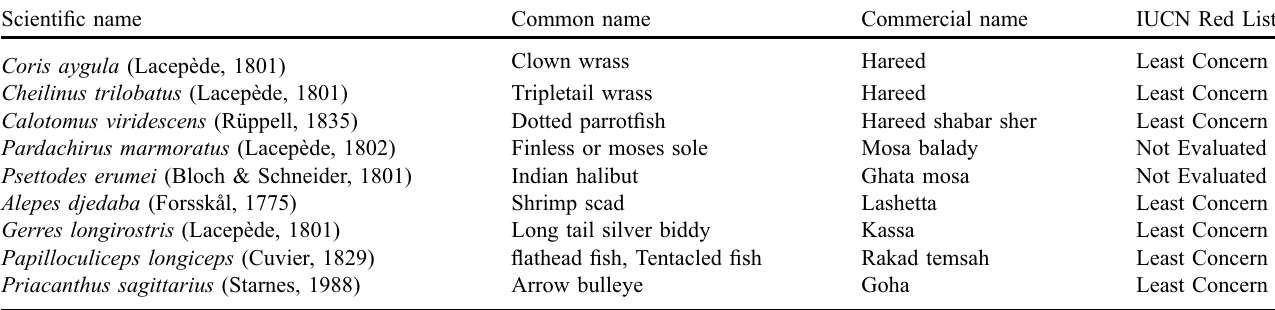
Table 1. Latin, English common, Egyptian commercial, and International Union for Conservation of Nature (IUCN)-Red list state of conservation of the fi shes identi fi ed in the current